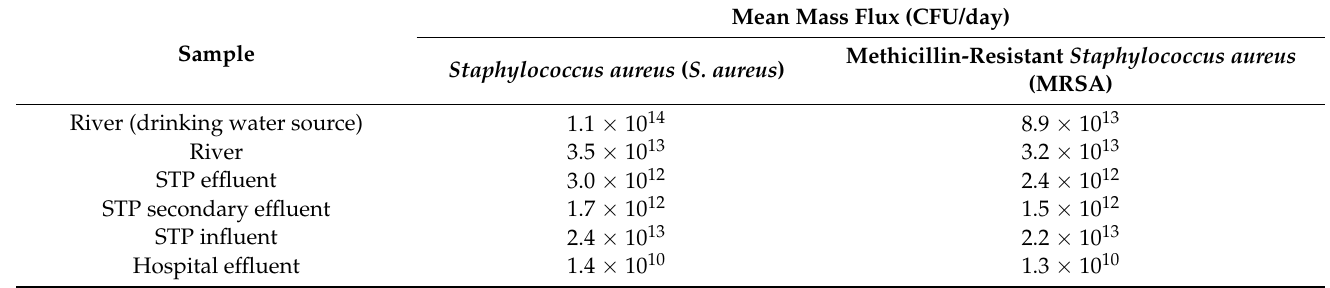
Table 2. Composition ratio of Staphylococcus aureus ( S. aureus ) and methicillin-resistant Staphylococcus aureus (MRSA) in each type of water sample.